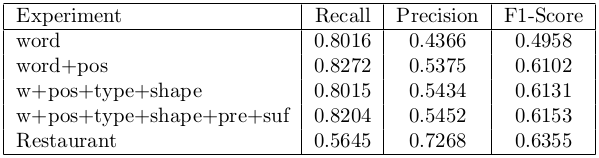
Table from the paper: Sentiment Analysis in Scholarly Book Reviews
Table text:
Experiment
Recall
Precision
F1-Score
word
0.8016
0.4366
0.4958
word+pos
0.8272
0.5375
0.6102
w+pos+type+shape
0.8015
0.5434
0.6131
w+pos+type+shape+pre+suf
0.8204
0.5452
0.6153
Restaurant
0.5645
0.7268
0.63555